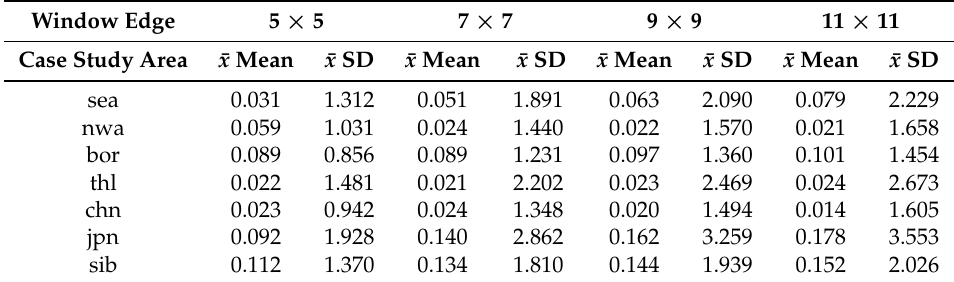
Table 7. Mean and standard deviation of the mean brightness temperature differences of each case study area for each 31-day period. Pixel values were averaged over the 31-day period for each site, and global means and standard deviations of these averages are reported.